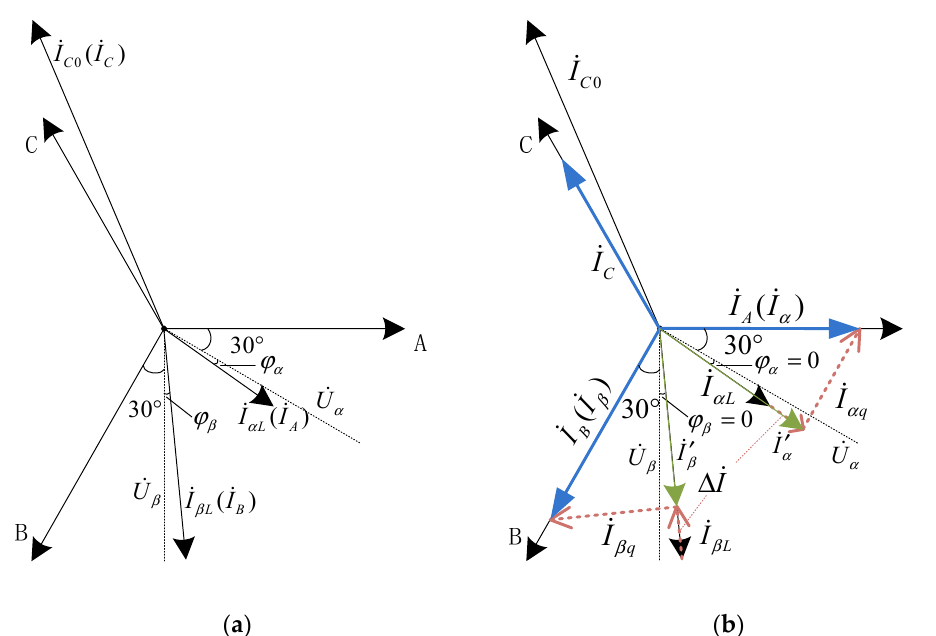
Figure 2. Phasor diagram of the V/v traction power supply system. ( a ) Without RPC compensation; ( b ) After RPC compensation. (In order to show the existence of ϕ α and ϕ β , although it is assumed that ϕ α = ϕ β = 0, U α ( U β ) and I α L ( I β L ) are not overlapped in the figure. In fact, under this assumption, U α ( U β ) and I α L ( I β L ) are overlapped.)